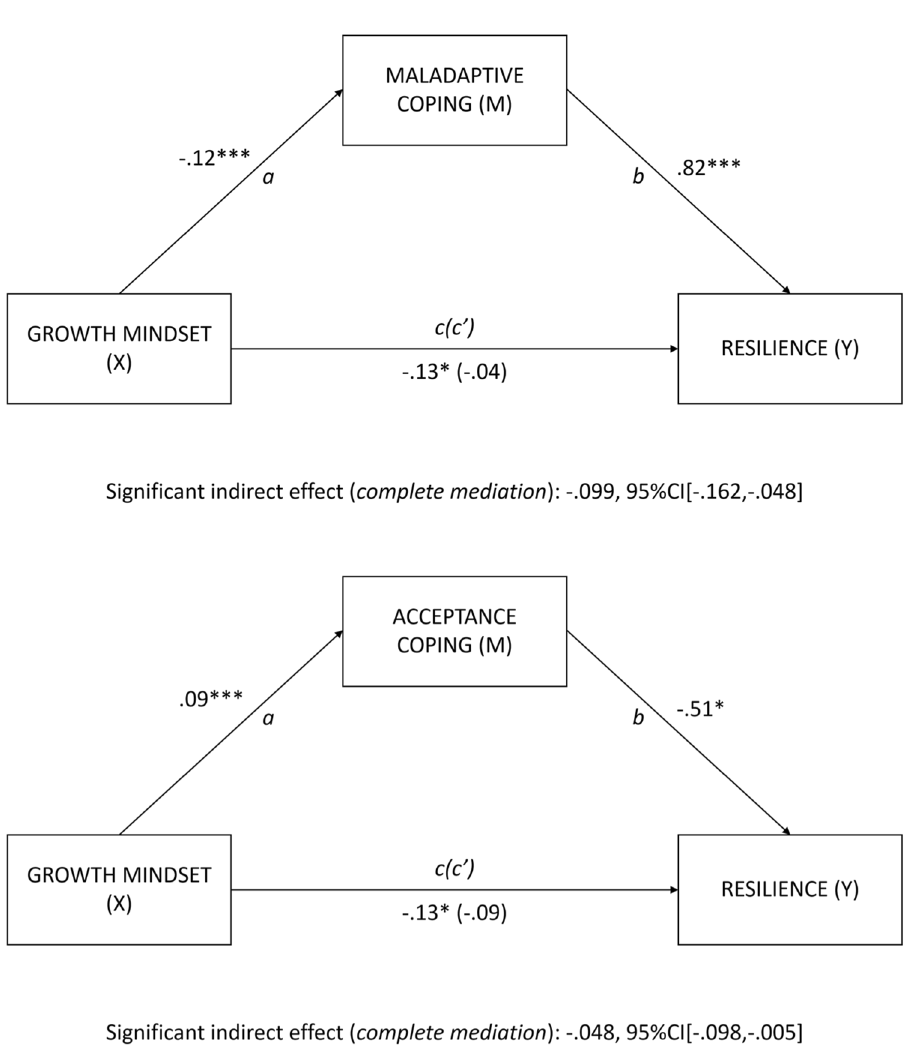
Figure 3. Mediation results: total sample. Note. N = 261. X = independent variable. Y = dependent variable. M = mediator. Note, growth mindset and coping styles were measured during the pandemic (T3). The resilience variable was defined as residuals of the regression between school burnout symptoms and COVID-related stress exposure (at T3), controlling for pre-pandemic school burnout symptoms (T2). Note that the resilience variable is reversed. * p < .05, ** < .01, *** < .001; path c’ = direct effect; numbers are beta